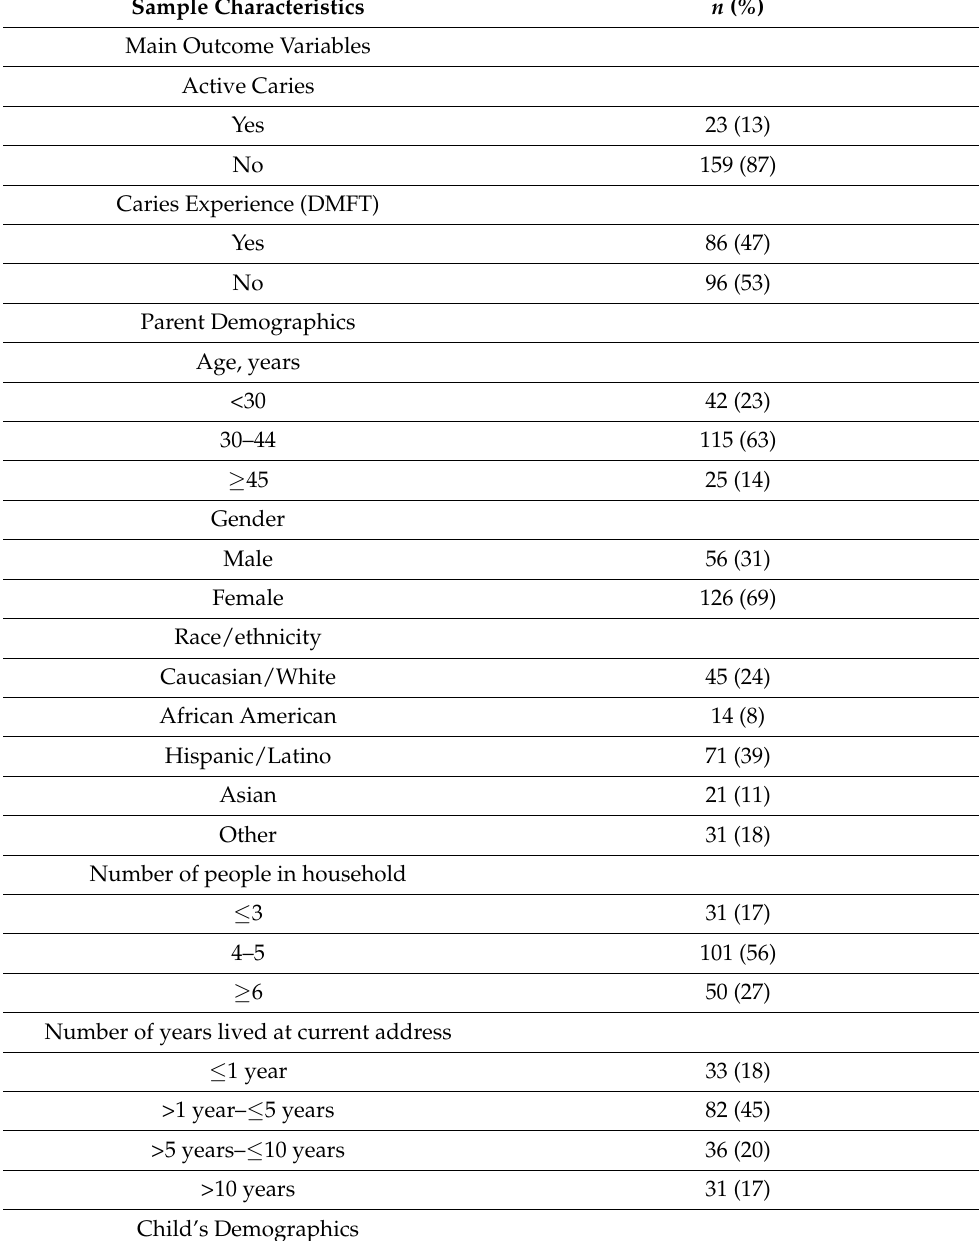
Table 2. Descriptive characteristics of main outcomes, demographics and oral health-related predictor variables ( n =